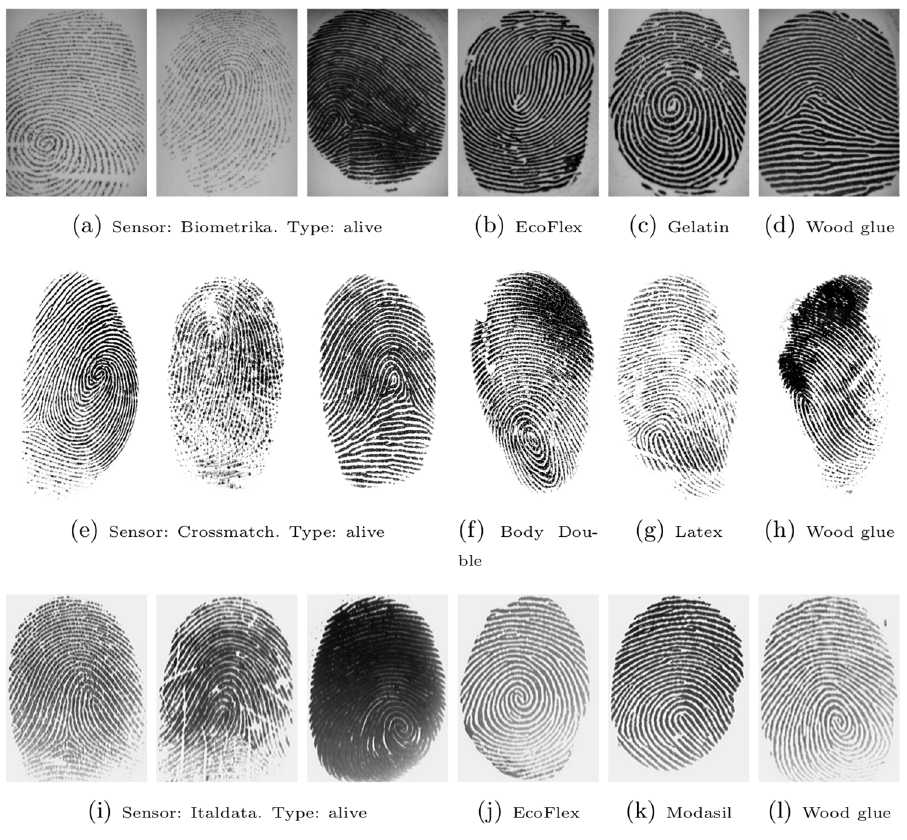
Fig 4. Example images from LivDet 2013 [42] after background removal by the FDB method[38]. The first row depicts images acquired on a Biometrika sensor, the second row from a Crossmatch sensor and the third row from an Italdata sensor. The leftmost three columns show images of real, alive fingers and rightmost three columns images of fake fingers (spoof material indicated in legend).